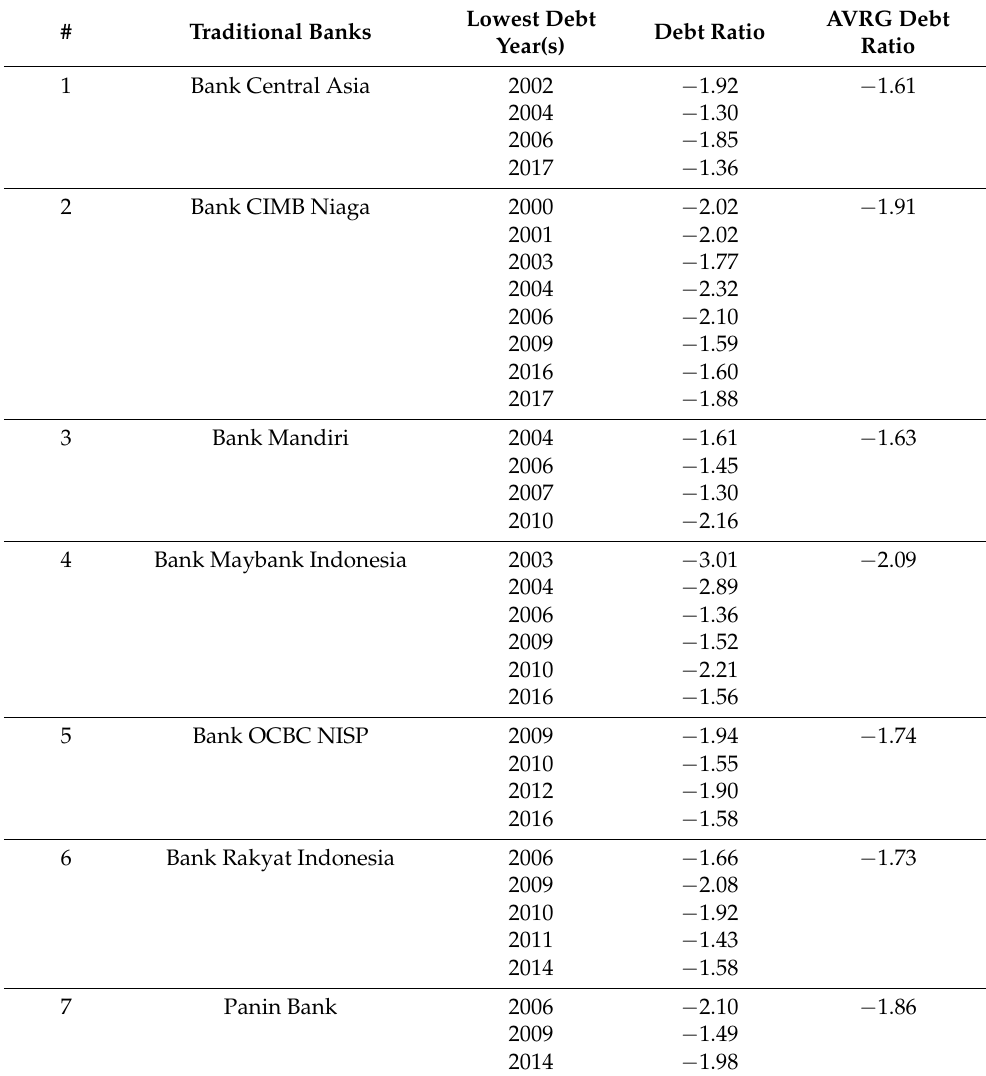
Table 3. Low Excess Leverage among Conventional Banks.